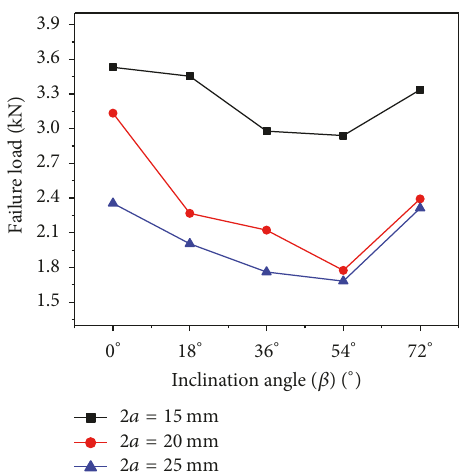
Figure 7: Failure load for the notched discs with preexisting